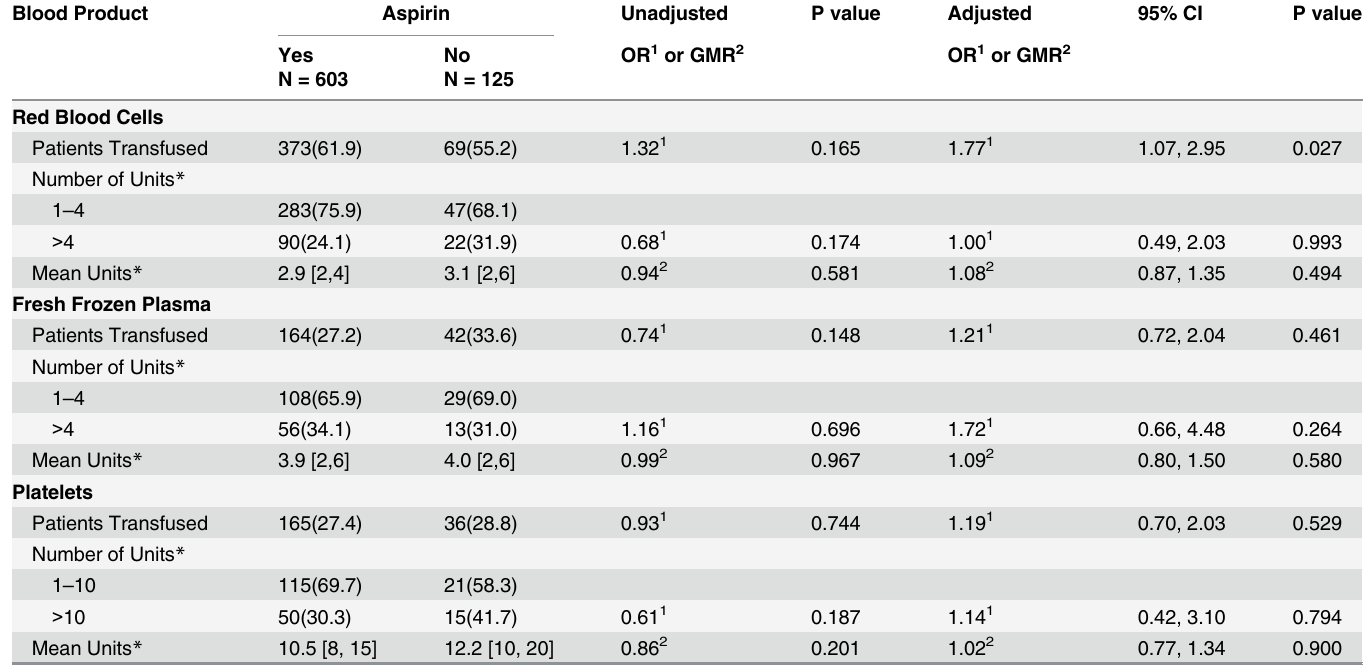
Table 2. Transfusion Outcomes, Aspirin vs No Aspirin. Blood Product